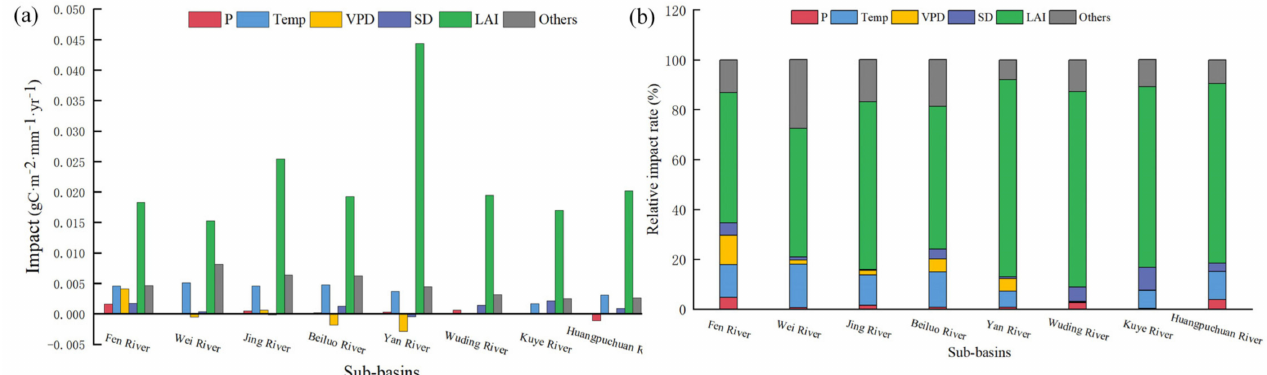
Figure 10. ( a ) Impact and ( b ) relative impact rates of the different impact factors on the WUE trend in the eight sub-basins in the Chinese Loess